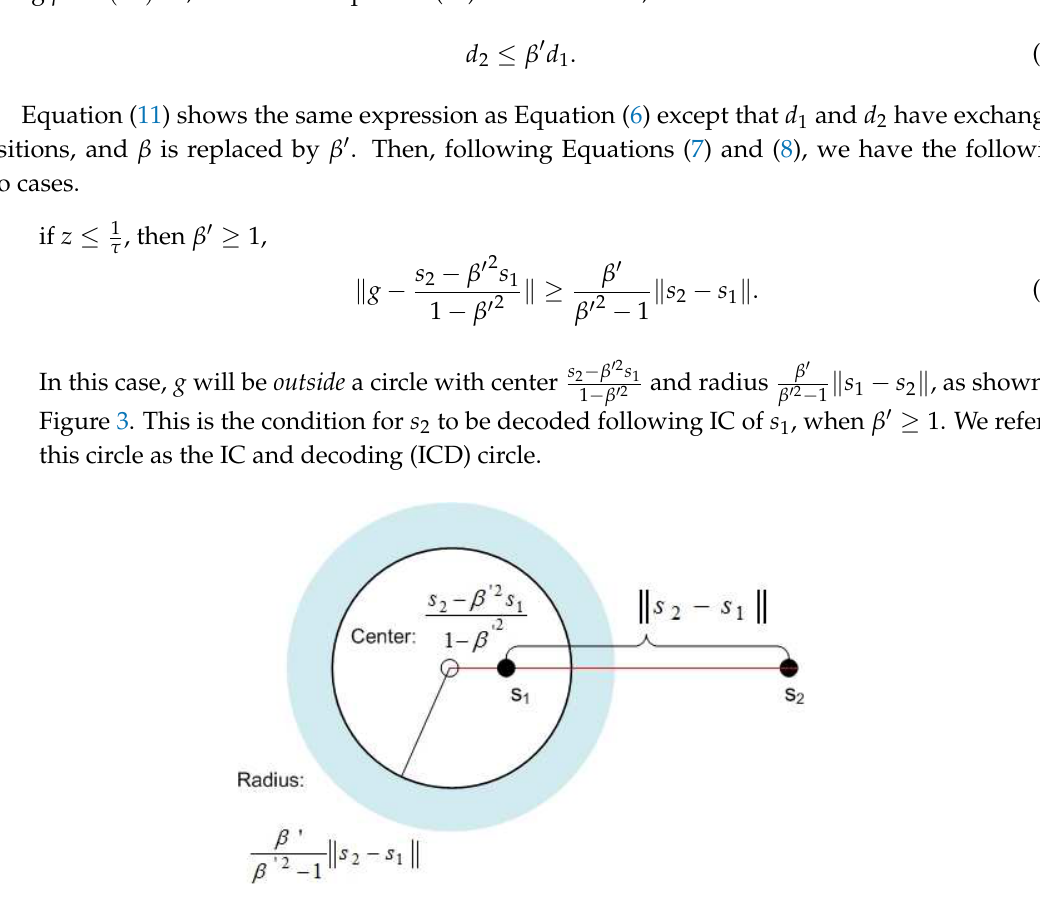
Figure 3. The blue regions outside of the circle are the ICD regions for s 2 , following IC of s 1 , for β (cid:48) ≥ 1.